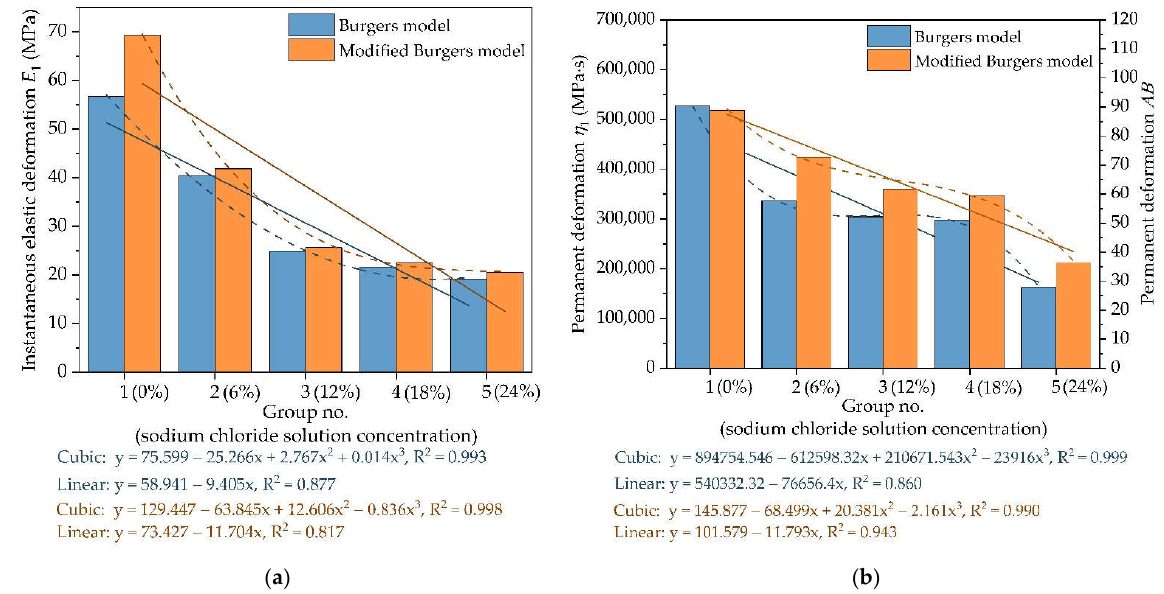
Figure 5. The variation of viscoelastic parameters with different chloride salt concentrations: ( a ) instantaneous elastic modulus; and ( b ) viscous resistance.